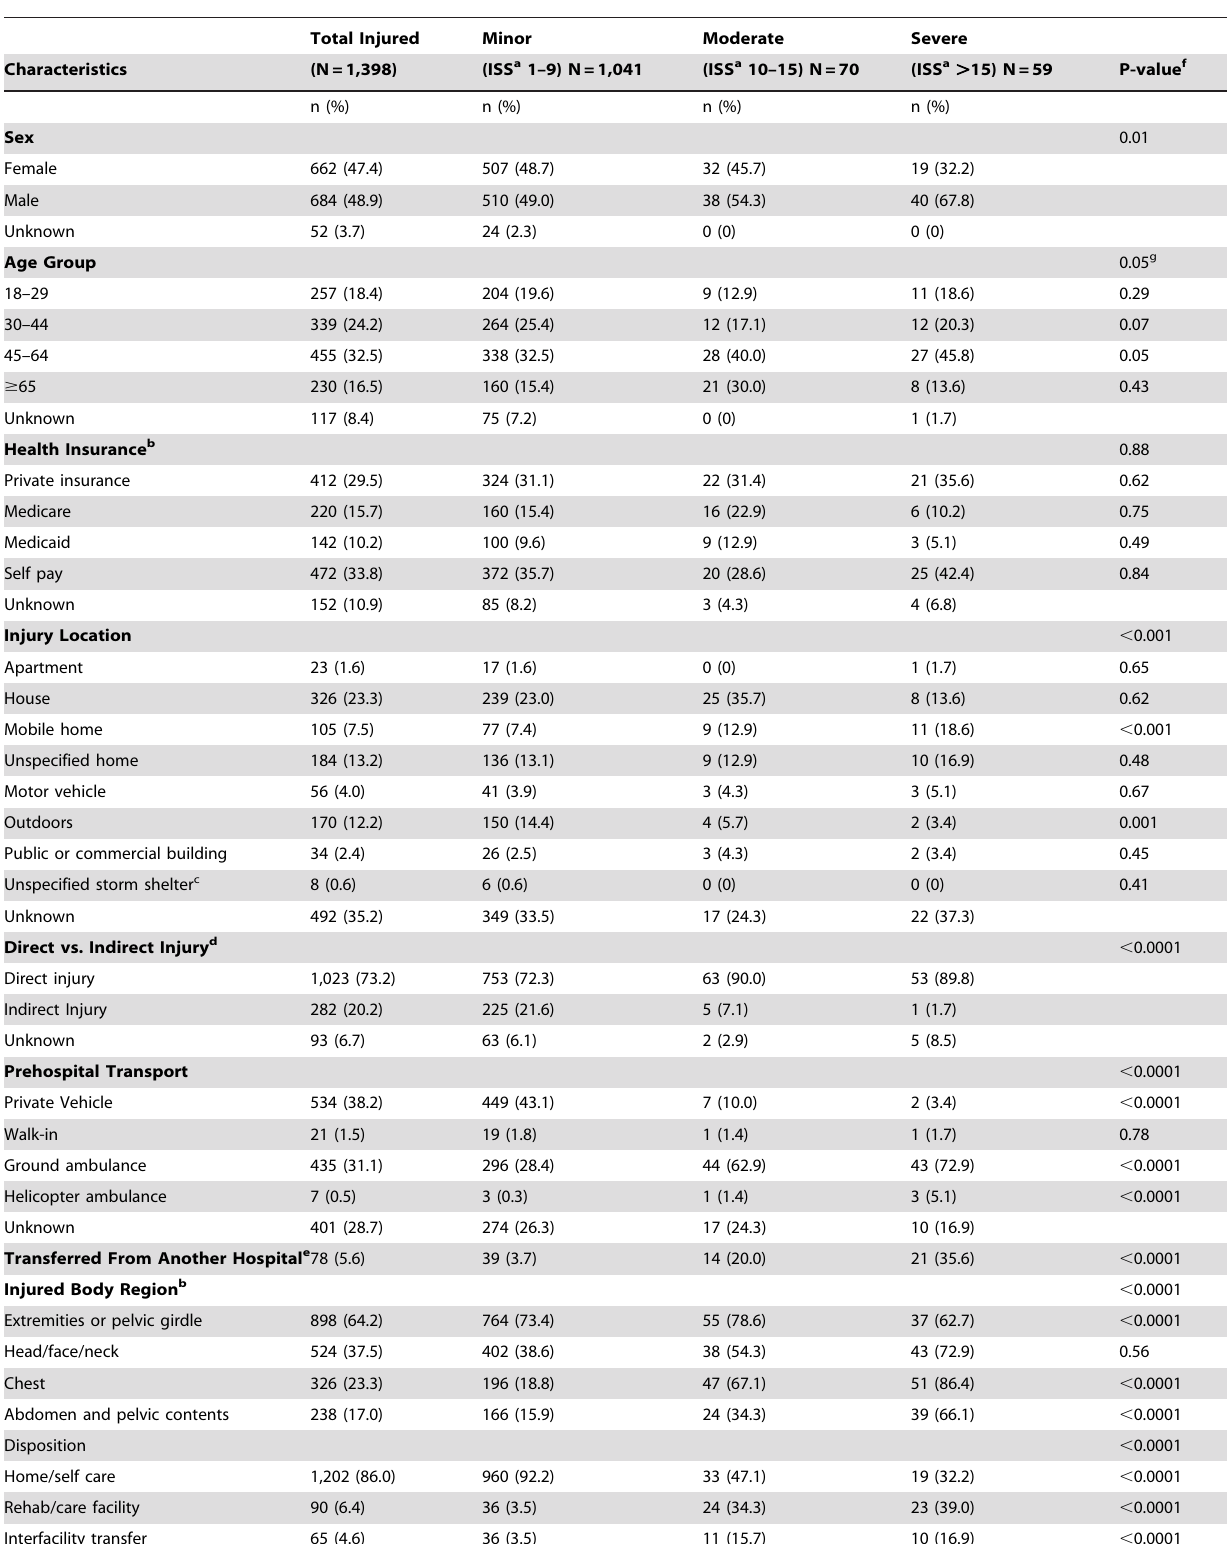
Table 1. Characteristics of patients with tornado injuries seen in emergency departments based on chart review—Alabama, April 27–30, 2011.